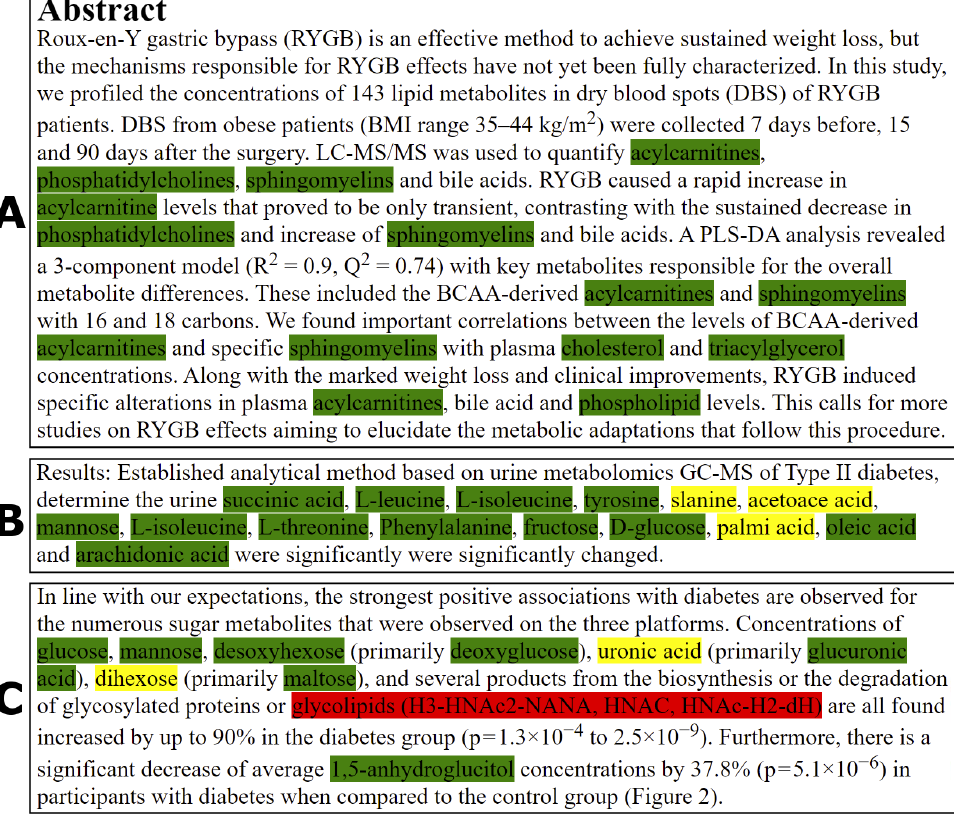
Figure 2. Examples of TABoLiSTM and rule-based annotation results visualised in annotated HTML files. Entities marked in green are recognised by both TABoLiSTM and the rule-based annotation pipeline, yellow entities are only recognised by TABoLiSTM, and red entities only by the rule-based annotation. ( A ) Excerpted from PMC6116856. ( B ) Excerpted from PMC4969426 and exemplifies typos. ( C ) Excerpted from